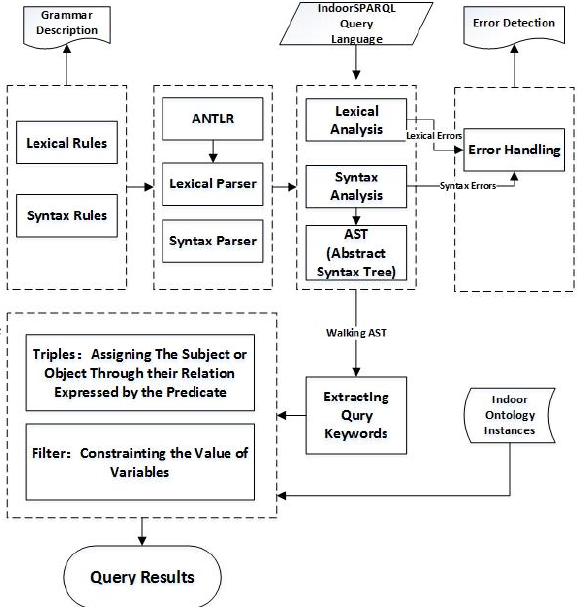
Figure 5. The Process of Parsing IndoorSPARQL